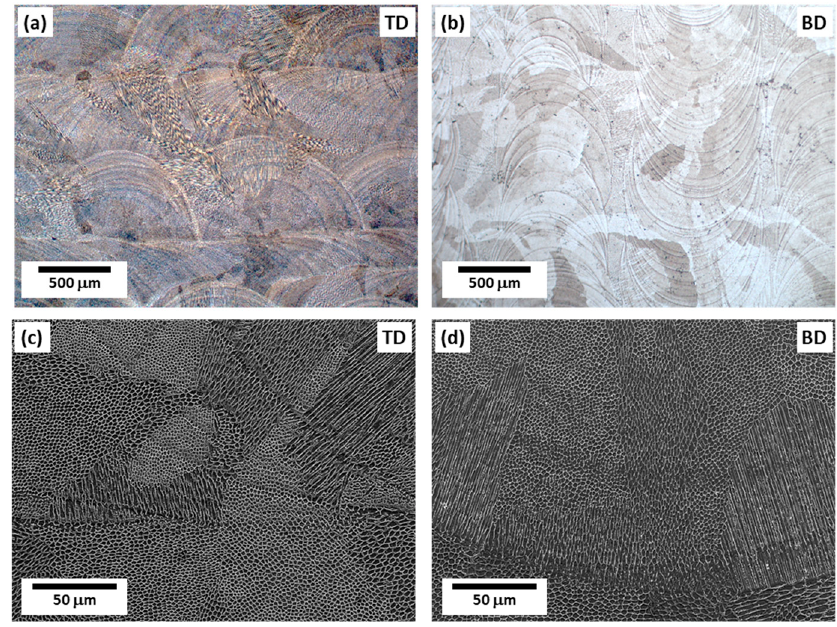
Figure 2. Microstructures of the specimen: ( a , b ) OM and ( c , d ) SEM images of the TD and BD planes, showing melt pool boundaries and cellular